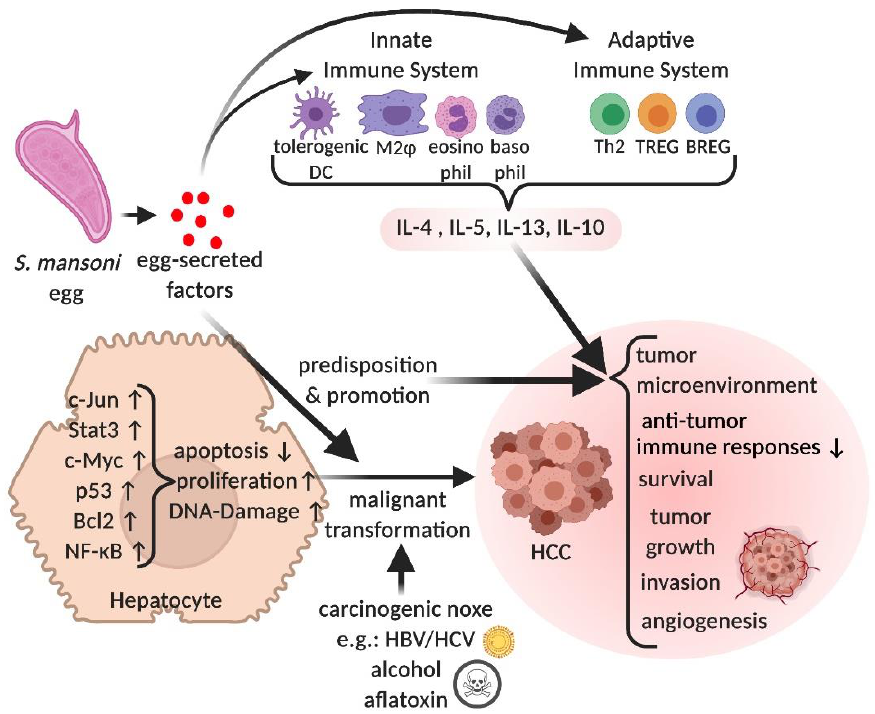
Figure 2. Egg-secreted factors induce tolerogenic and cancer-promoting immune modulations, i.e., the suppression of anti-tumor immune responses, and contribution to the development of an immunosuppressive tumor microenvironment. Egg-secreted factors trigger cellular processes that may predispose hepatocytes to neoplastic transformation or promote malignancy. Created with BioRender.com, online link: https://biorender.com/ (accessed on 25 March 2021).